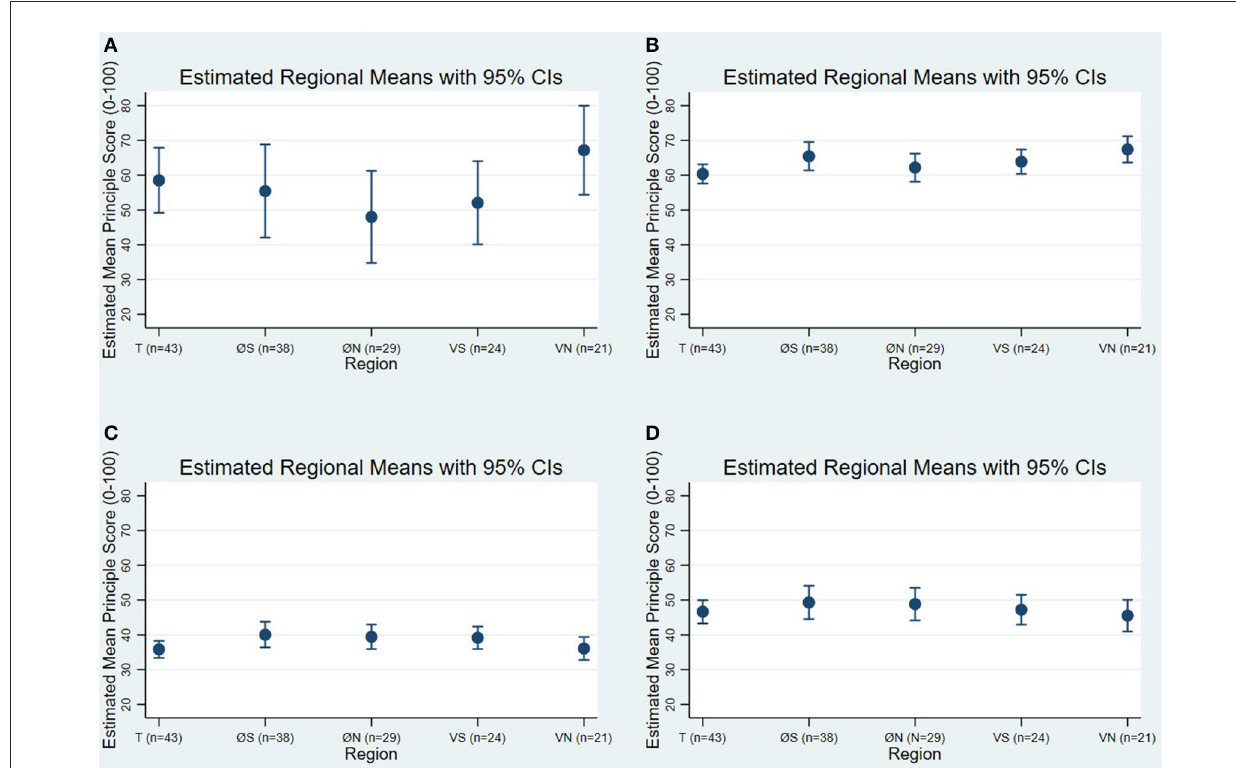
FIGURE3 Margins plots visualizing the estimated mean scores for the five regions and their 95% confidence intervals (CIs) based on the best fitted generalized linear models (A) Good feeding, (B) Good housing, (C) Good health, and (D) Appropriate housing, as described in Table 3. The regions are labeled